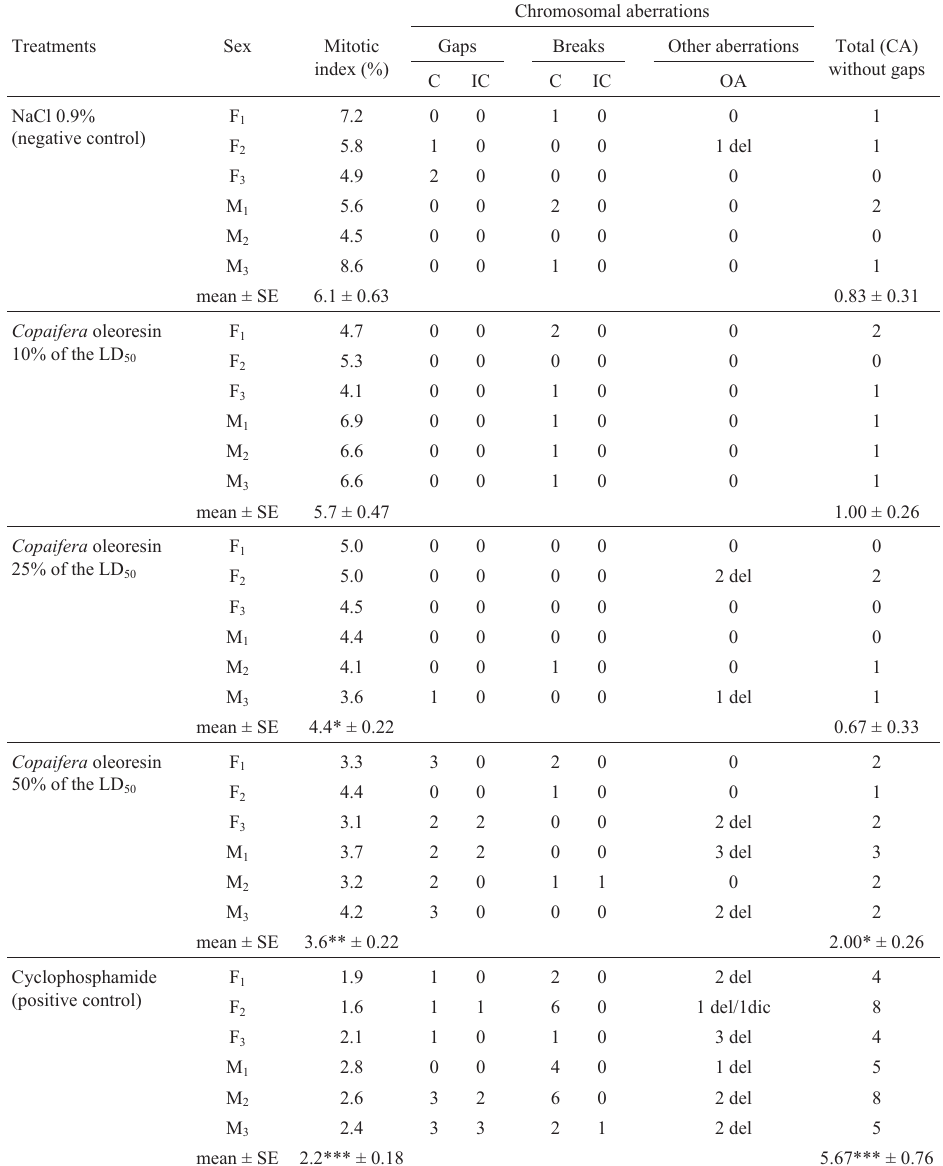
Table 2 - Mitotic Index and distribution of the different types of chromosomal aberrations (CA) observed in bone marrow cells of female (F 1 to F 3 ) and male (M 1 to M 3 ) Wistar rats treated with a Copaifera duckei oleoresin. For each treatment 100 cells per animal were analyzed, giving a total of n = 600 cells per